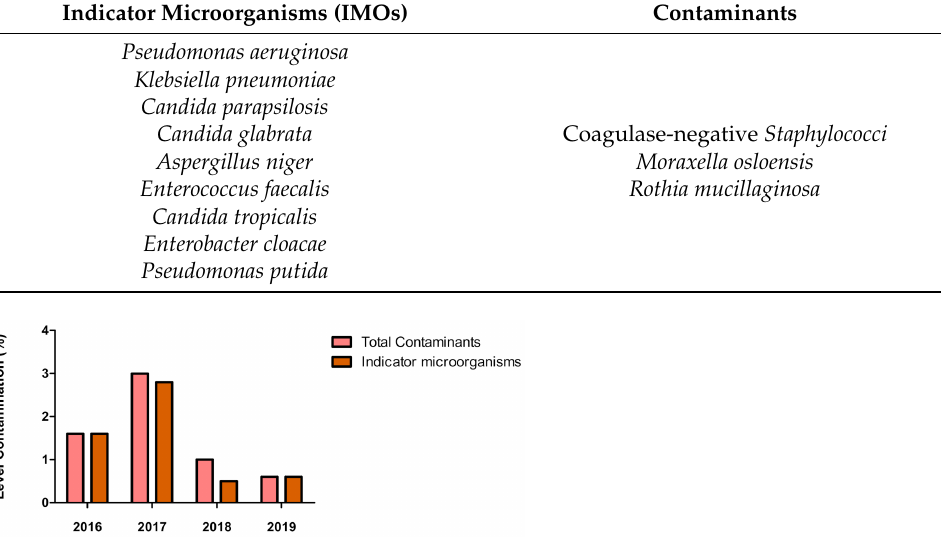
Figure 2. Levels of total contaminants and Indicator microorganism (IMOs) per year. Out of 12 positive samples, nine were due to IMOs and three were due to environ- mental or commensal microorganisms (Table 1). In one bronchoscope, in 2019, both IMOs and contaminants CFU equal to 10 were detected (data not shown). For all purposes, this instrument was considered positive due to the presence of